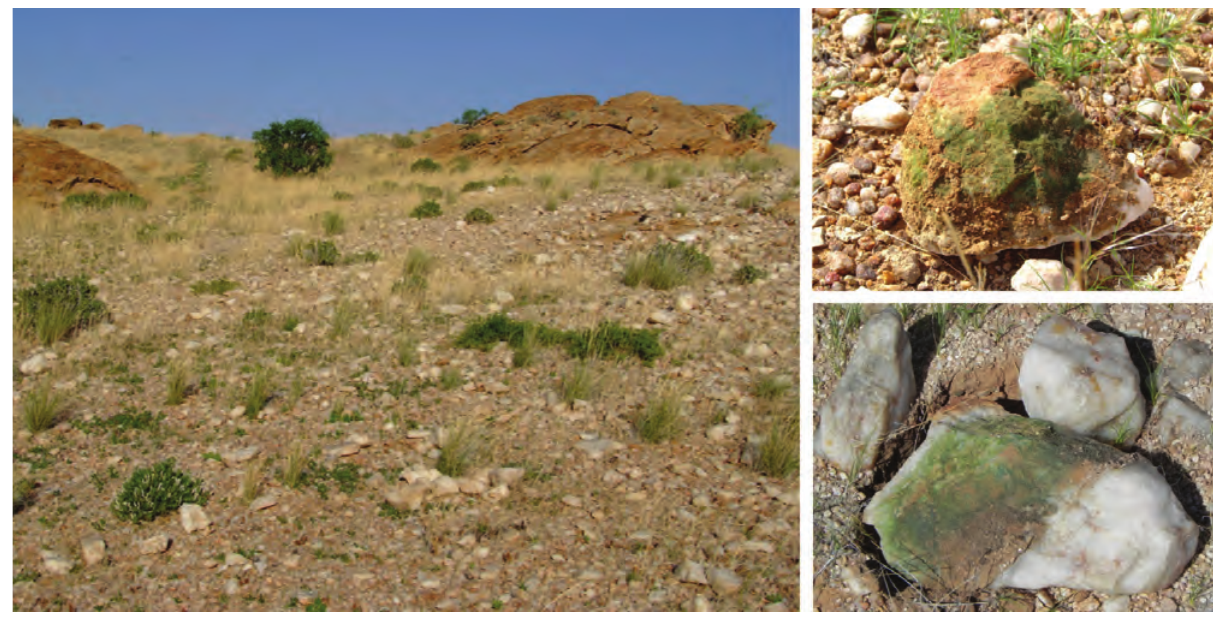
South Africa’s cryptic biodiversity. Deserts, which cover a substantial proportion of South Africa’s land area, are extreme environments where microorganisms inhabit specialised, often cryptic (hidden) niches. Hypolithic communities, found on the undersides of translucent rocks, represent ‘hotspots’ of microbial